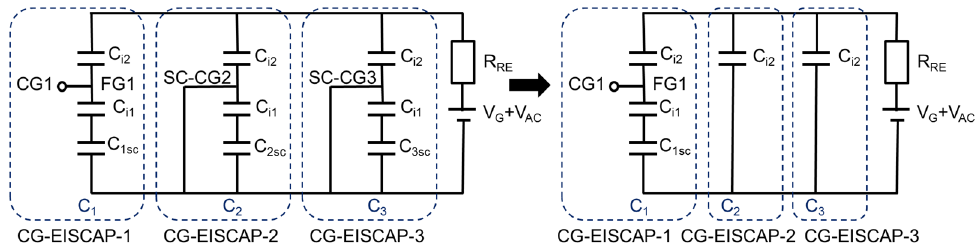
Figure 4. Equivalent circuit of the chip in floating/short-circuited CG setup. SC-CG2 and SC-CG3: short-circuited CG2 and CG3, respectively. All other terms are described in Figure 3. To detect target analyte T1 with the CG-EISCAP-1, CG1 is kept floating (CG1